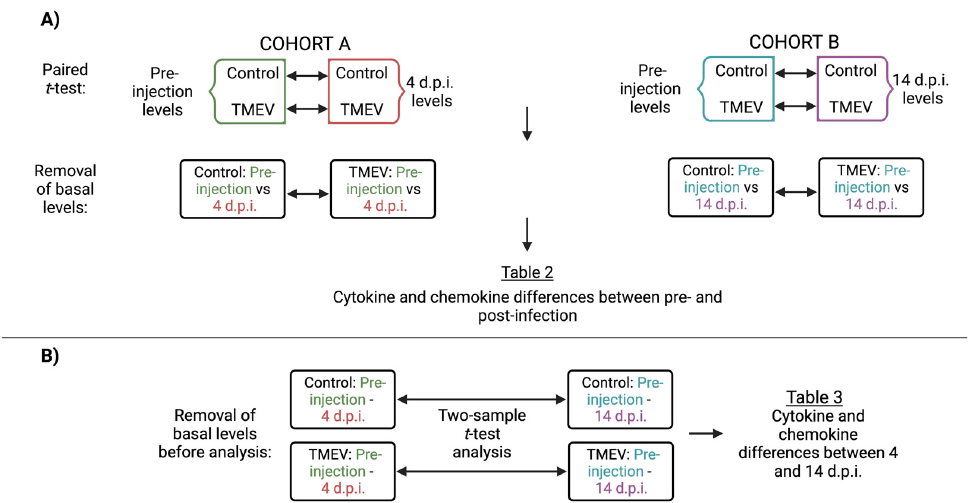
Figure 2. Step-by-step analyses revealed cytokines and chemokines with changes attributable solely to immune responses to the i.c. injection for each strain. ( A ) Paired t -test analysis to determine differences between pre-and post-injection responses (pre-injection vs. 4 d.p.i. and pre-injection vs. 14 d.p.i.). ( B ) Two-sample t -test analysis to identify differences between the 4 and 14 d.p.i. period after normalizing both post-injection time points with their respective pre-injection values (Created with BioRender.com).